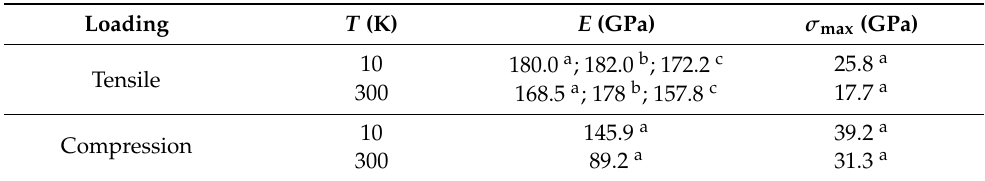
Figure 2. Engineering strain-stress curve for uniaxial tensile loading of TiAl alloy in the <001> direction. The black and red circles represent the loading process at 10 and 300 K, respectively. Table 1. The Young’s Modulus E and ultimate strength σ max for uniaxial tensile and compressive loading of TiAl alloy in the <001> direction at 10 and 300 K.